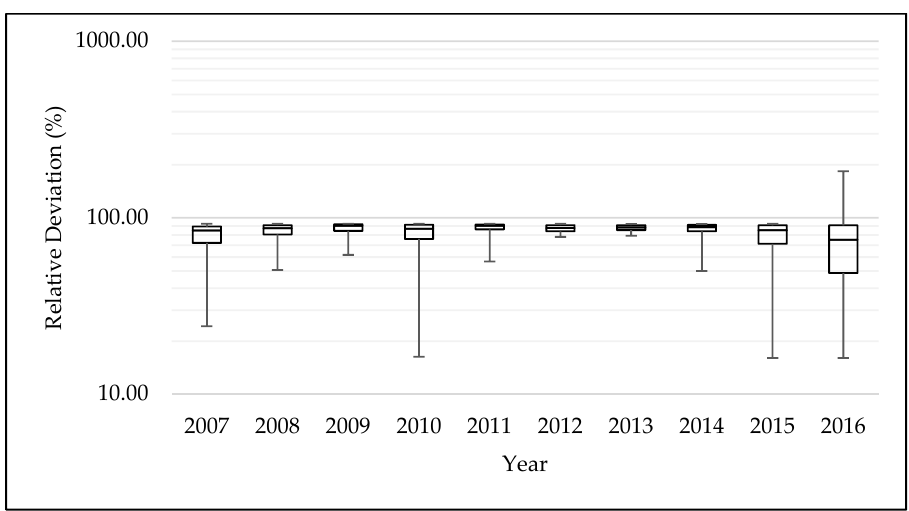
Figure 9. Relative deviation of 2007 to 2016—GLUE.